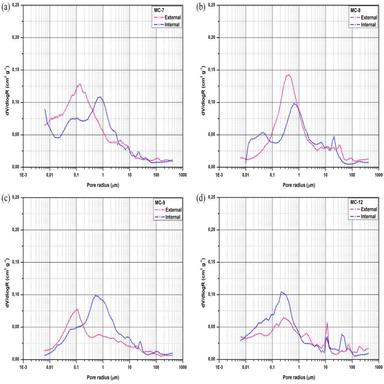
Pore size distribution curves obtained with mercury intrusion porosimetry (MIP) for RE samples.